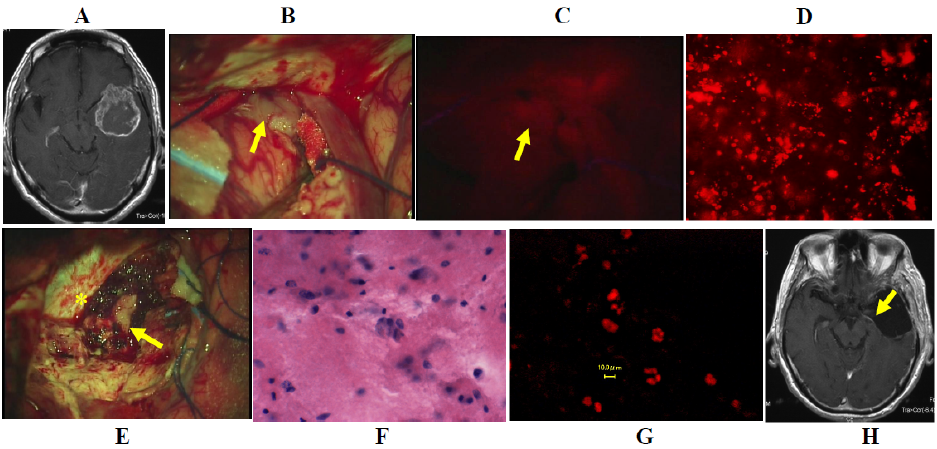
Figure 5. Illustrative case ten. ( A ) Gadolinium-enhanced T1-weighted axial MR image demonstrating a heterogeneously enhanced glioblastoma lesion in the left temporal lobe. ( B ) The tumor tissue showed exophytic growth in the left temporal lobe (yellow arrow) on the surgical microscopy. ( C ) Strong fluorescence was detected on surgical microscopy (yellow arrow) for photodiagnosis. ( D ) A total of 412 polymorphic tumor cells emitting fluorescence were detected in the tumor bulk tissue under fluorescence microscopy using the Cy 5 filter. ( E ) After resection of the tumor bulk, the hippocampal head (yellow arrow) showed a normal appearance under surgical microscopy. ( F ). Hematoxylin and eosin staining of crush smear tissue of the hippocampal head demonstrated infiltrating multinucleated tumor cells under the white light of the fluorescence microscopy. ( G ). Infiltrating tumor cells in the tissue in ( F ) demonstrated strong fluorescence on the fluorescence microscopy using the Cy 5 filter. ( H ). Postoperative gadolinium-enhanced T1-weighted axial MR image demonstrated complete resection of the tumor bulk and additional resection of the hippocampal head (yellow